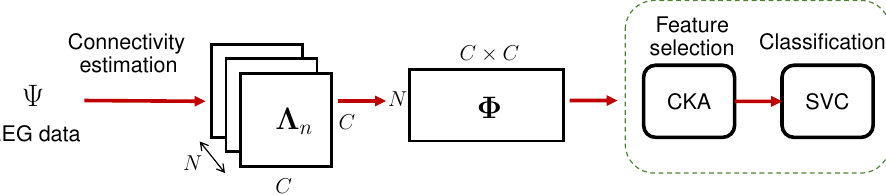
Figure 4. Schematic representation of our overall classification